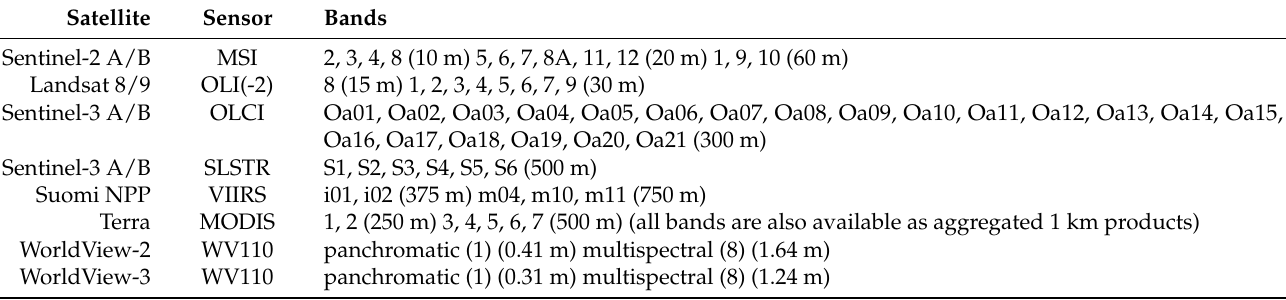
Table 1. Summary of band details of the input data with their native resolutions used in this study. The sensor abbreviations are MultiSpectral Instrument (MSI), Operational Land Imager (OLI), Ocean and Land Colour Instrument (OLCI), Sea and Land Surface Temperature Radiometer (SLSTR), Visible Infrared Imaging Radiometer Suite (VIIRS), MODerate Resolution Imaging Spectroradiometer (MODIS) and WorldView-110